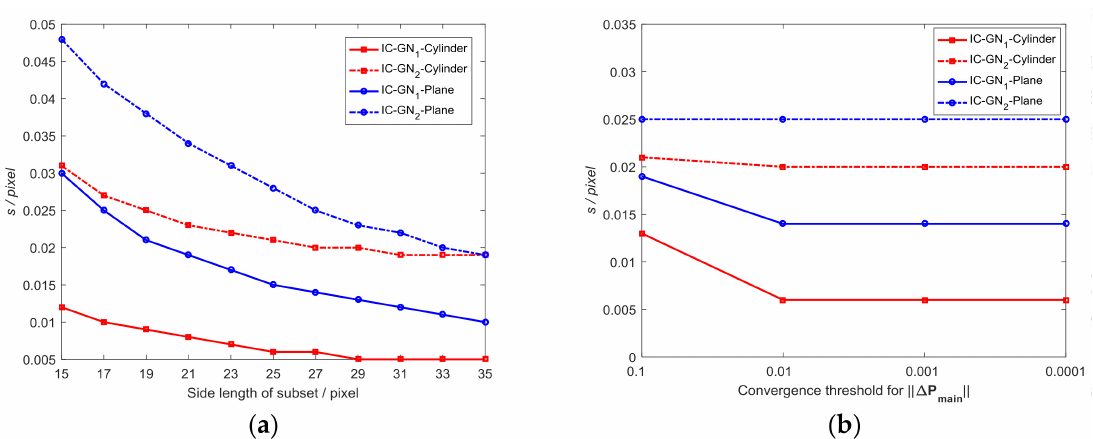
Table 4. Statistics of matching rates with different subset sizes measured by IC-GN 1 and IC-GN 2 .